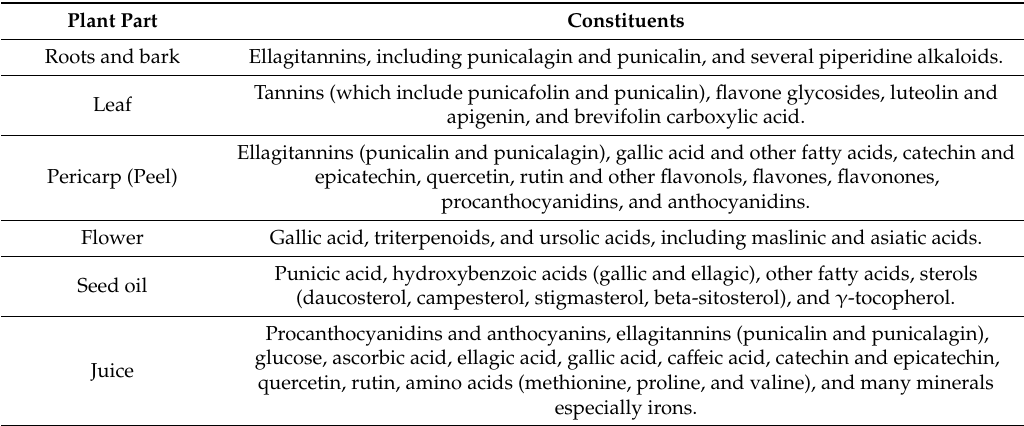
Table 3. Phytochemical constituents in di ff erent parts of the pomegranate plant ( P. granatum L.) [45,65]. Plant